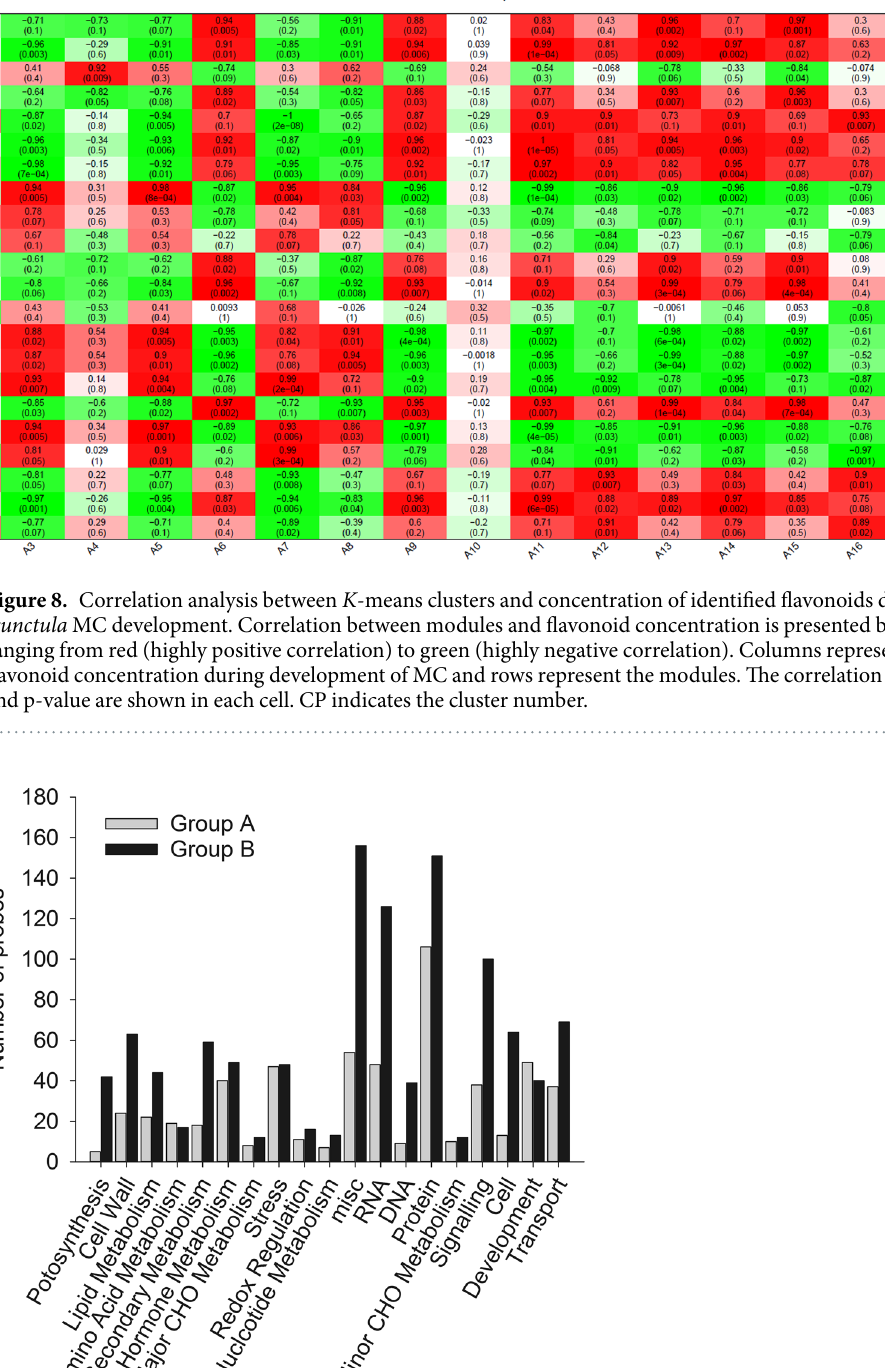
between gene expression level and flavonoid accumulation during MC development by constructing a weighted gene co-regulatory network (WGCNA) (Fig. 8). Four flavonoids, i.e., A3 (leucodelphinidin), A5 (epicatechin 3-O-glucoside), A7 (epicatechin), and A8 (catechin), were significantly positively associated with six clusters (Group A: CP8, 14, 15, 16, 18, and 19, total of 603 genes) and negatively related to 12 other clusters (Group B: CP1, 2, 4, 5, 6, 7, 11, 12, 17, 20, 21, and 22, total of 1177 genes). Eight flavonoids, i.e., A6 (luteolin 3-O-glucoside), A12 (myricetin 3-O-galactoside-malatone), A13 (rutin), A15 (quercetin 3-O-Glucoside-6 ″ -acetone), A9 (myricetin